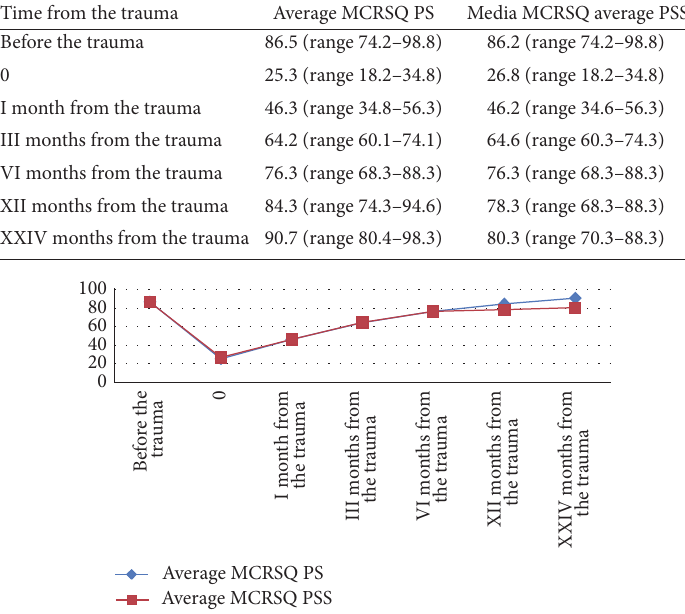
Figure 3: Trend of knee function and quality of life related to it for two-year follow-up measured by the Modified Cincinnati Rating System Questionnaire (MCRSQ). At twelve months there was a statistically significant difference ( 𝑝 < 0.05 ) in favor of the PS